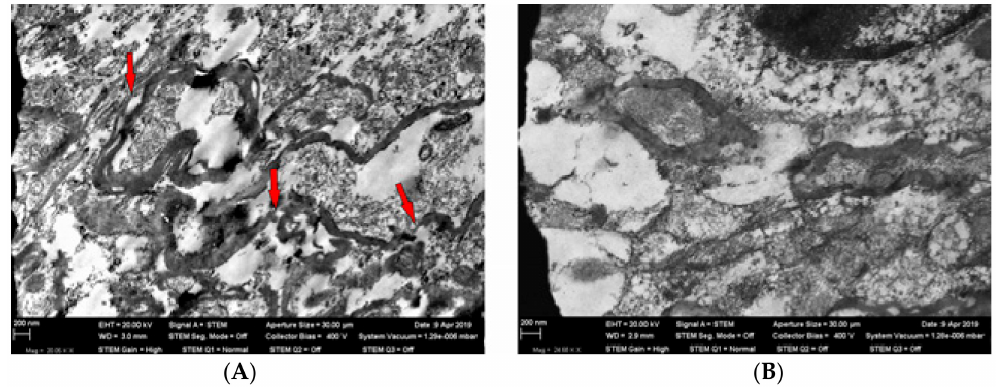
Figure 3. Panel ( A )—a neuron body with numerous nanoparticles (shown by red arrows) and vacuolized cytoplasm (shown by a red asterisk); TEM, magnification × 41,950; Panel ( B )—non-damaged neuron bodies in the olfactory region of a rat brain from the control (sham-exposed) group; TEM, magnification × 10,410.